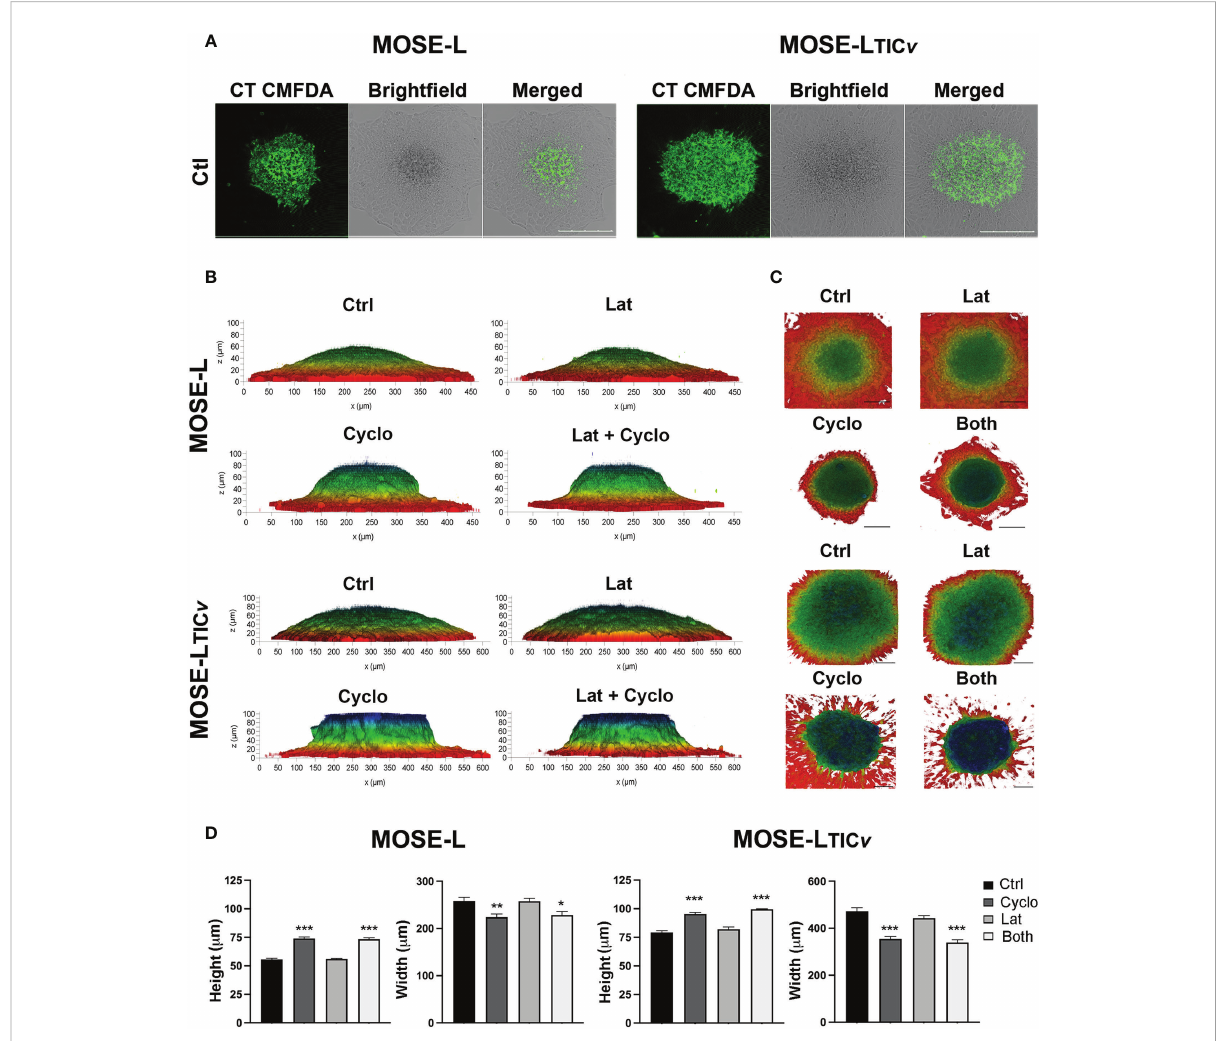
FIGURE 7 Spheroidal outgrowth results from proliferative and migratory signaling. (A) Confocal images of spheroids outgrowth layer from cell-tracker CMFDA stained spheroids adhered for 24 h were treated with Cyclo and Lat A (A) Spheroids outgrowth layer from cell-tracker CMFDA stained spheroids adhered for 24 h treated with Cyclo and Lat A (B) Side-view pro fi les of drug-treated spheroids observed through 3D reconstruction of 100 µm optical z-stacks using the Leica LASX software depth-coded to show z-pro fi les. (C) Top-view perspectives of spheroidal spread and outgrowth production depth coded to show z-pro fi les. Scale bar set at 200µm. (D) Quanti fi cation of height and width (MOSE-L and MOSE- LTIC v ) of spheroids from (B) using ImageJ. *p<0.05, **p<0.01, ***p<0.001 treatment compared to the control